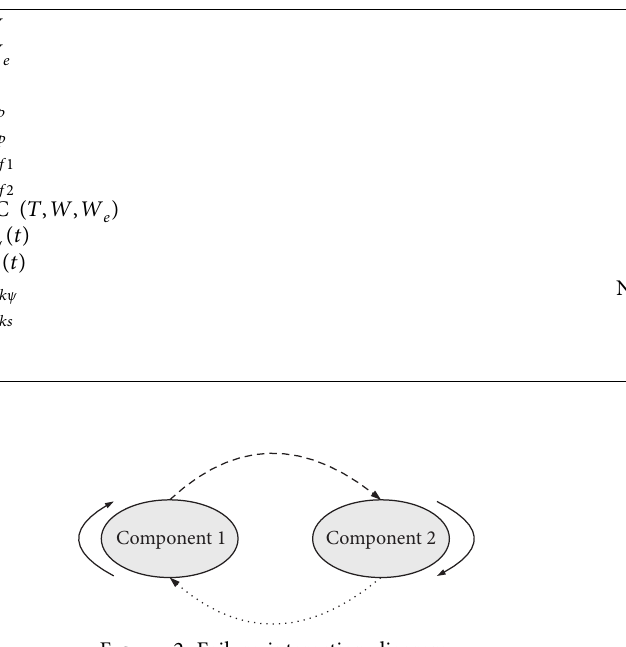
Figure 2: Failure interaction diagram.